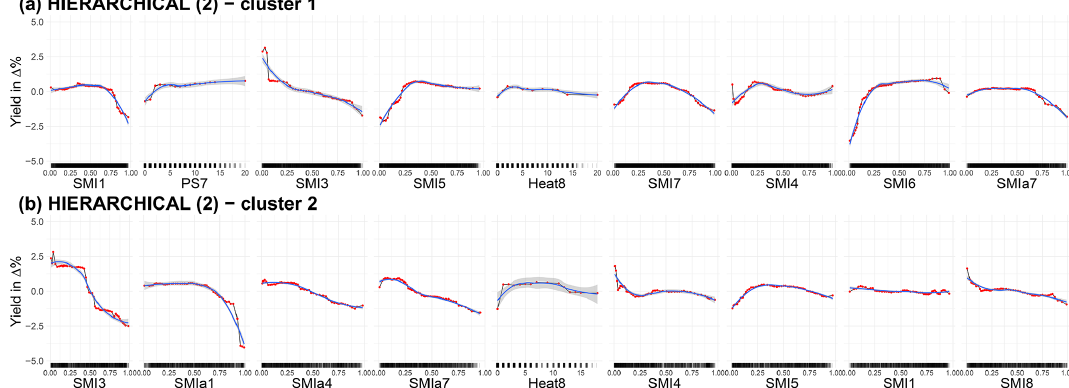
Figure A7. ALE plots for the best combination of cluster algorithm and cluster size (HIERARCHICAL with two clusters) for a soil moisture index configuration that considers both the uppermost 25cm as well as the entire soil column. For both clusters, the nine ALE plots with the highest feature importance are shown. The importance ranking is established with 50 repetitions. We have chosen a grid size of 50 to estimate the ALE plots, which allows us to reveal the true complexity of the model at the expense of shakiness. Therefore a non-linear smoothing function (LOESS – locally estimated scatterplot smoothing) is added in blue (with the confidence interval in grey). SMI represents the soil moisture index for the uppermost 25cm of the soil column, PS stands for days without rain in a given month, and Heat stands for days with a maximum temperature of more than 30 ◦ C. The number indicates the month; October (10) to December (12) refers to the year before.